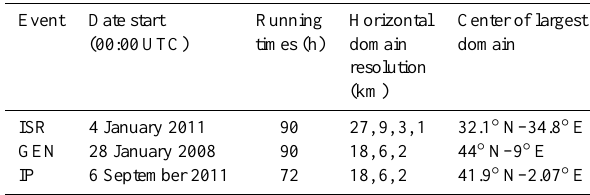
Table 1. Start and run times, nested domains, and the location of the largest domains used for each event in the WRF-ARW